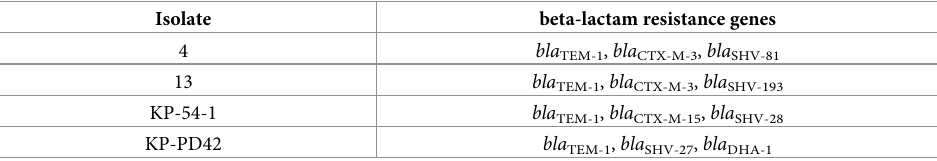
Table 4. The beta-lactam resistance genes of four ESBL-KP isolates.